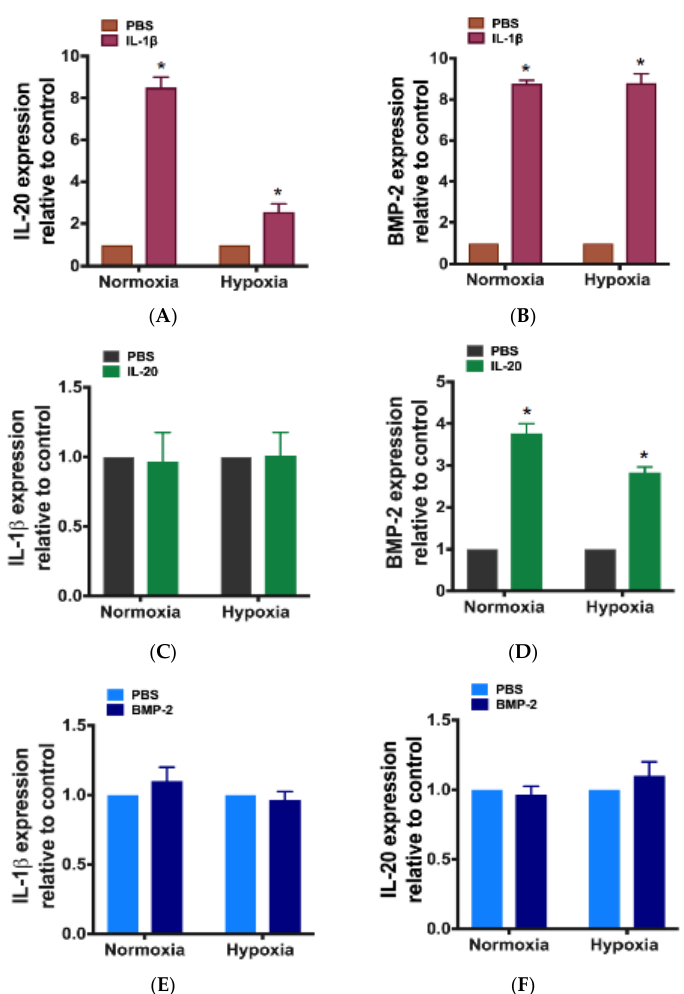
Figure 5. The regulation of IL-1 β , IL-20, and BMP-2 in IVD cells. IVD cells were exposed to PBS, IL-1 β (10 ng / mL), IL-20 (200 ng / mL), and BMP-2 (200 ng / mL) under normoxia or hypoxia for six hours. ( A – F ) The expression levels of indicated genes were analyzed using RT-qPCR with specific primers. β -actin was an internal control. * p < 0.05 compared with PBS-treated controls. Data are expressed as mean ± SD and are representative of three independent